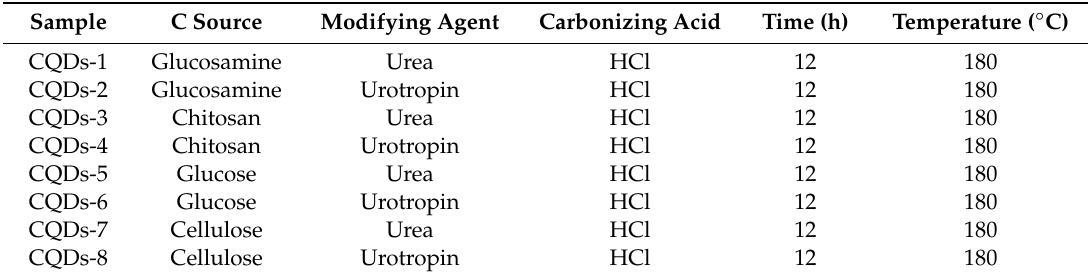
Table 1. Samples